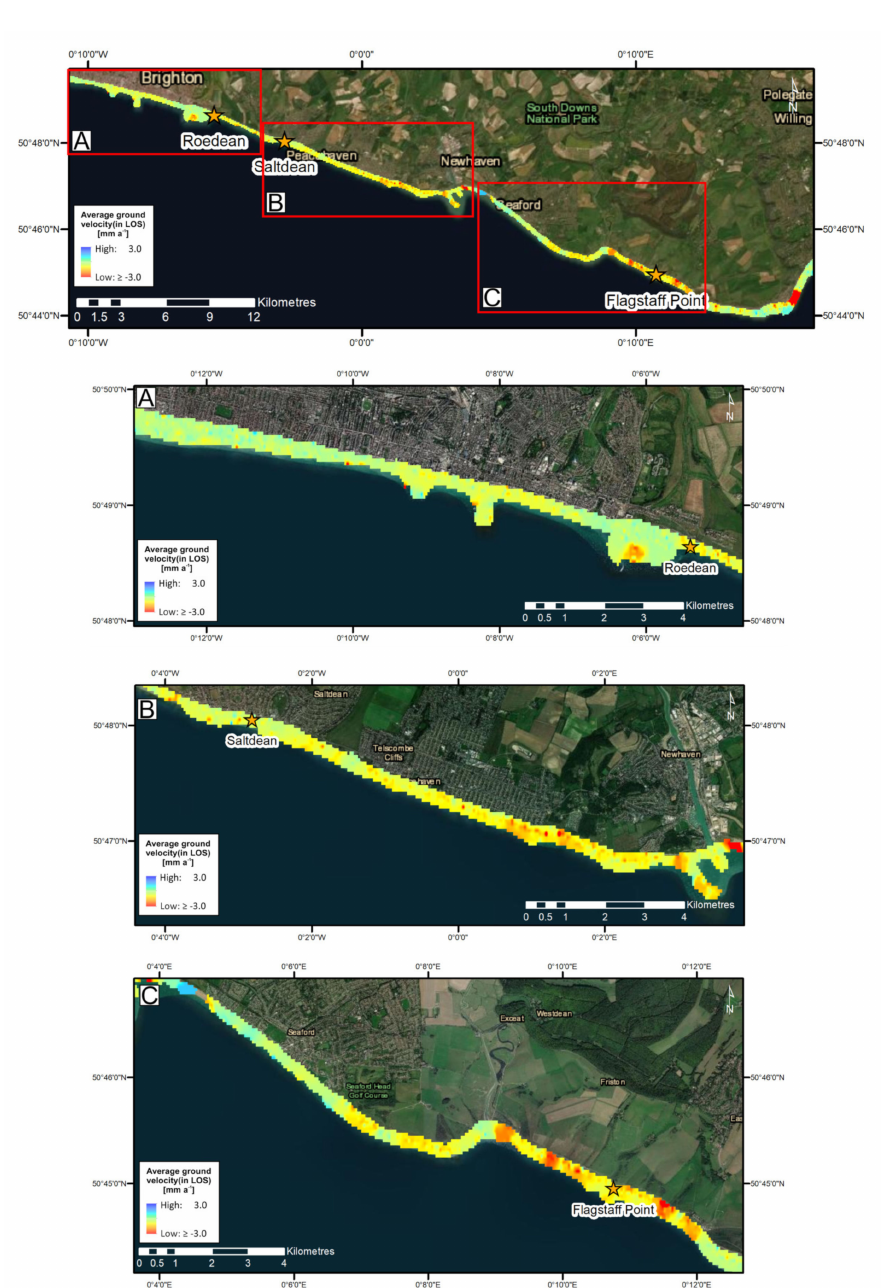
Figure 9. Regional map, presenting the average velocity for the research area from Brighton in the west to Eastbourne in the east, overlain on the ArcGIS Online World Imagery. Red colour indicates moving in the downward direction (away from the satellite), blue moving upwards (towards the